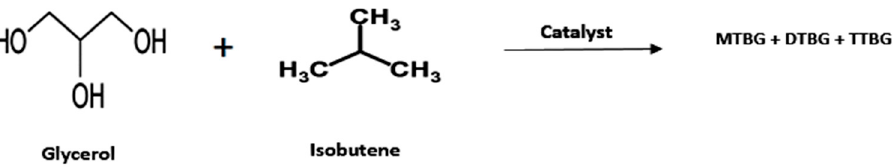
Scheme 3. Conversion of glycerol to glycerol ether using alkenes.